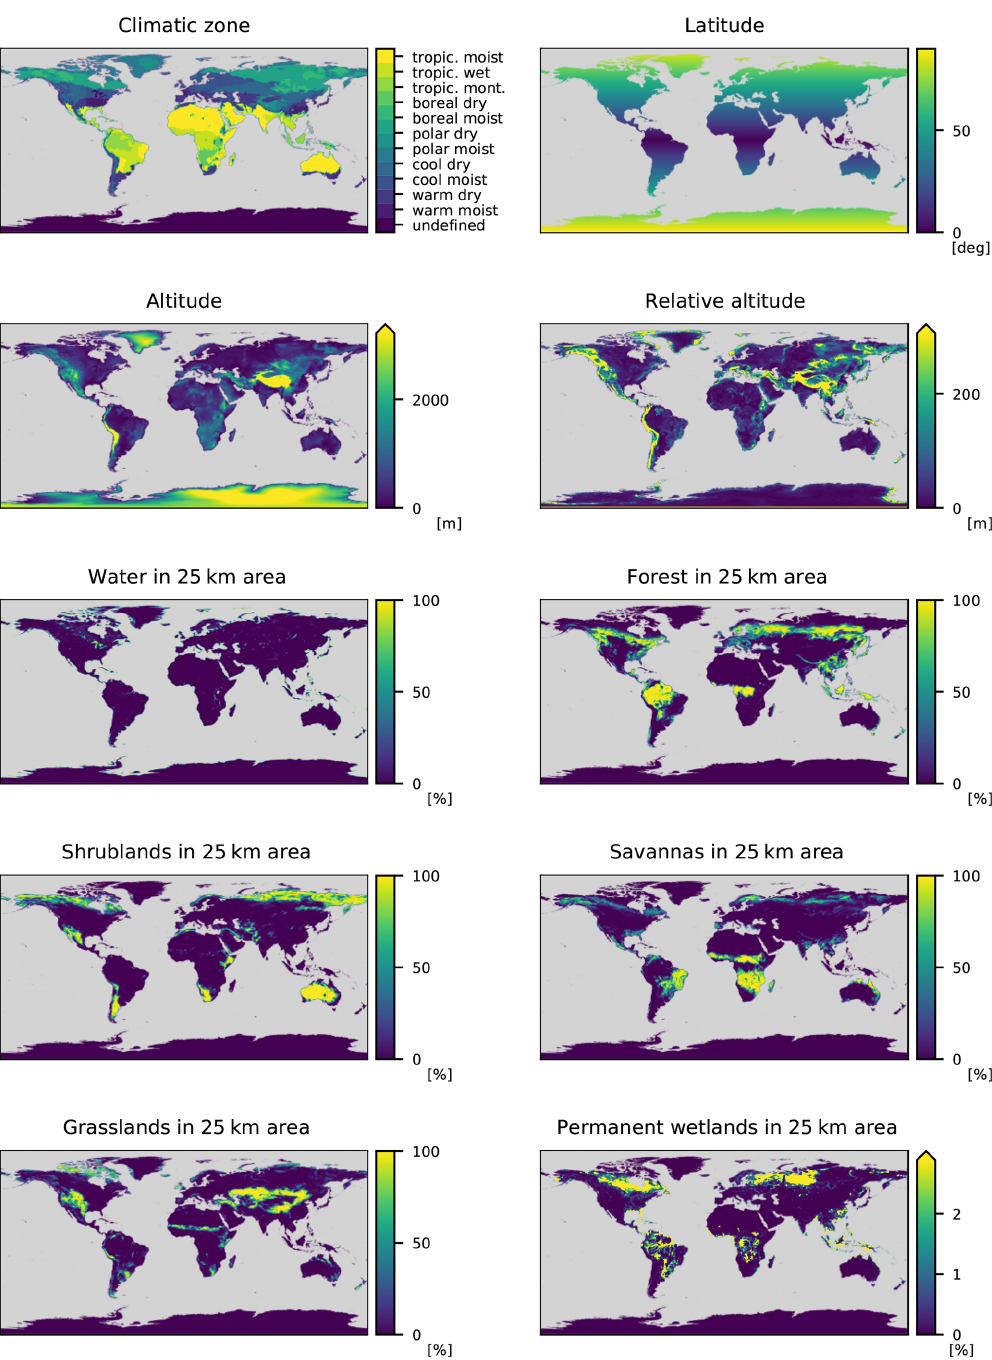
Figure B1. Gridded fields used for the final map production. Please note that the feature engineering was done as described in Sect. 2.2.2.